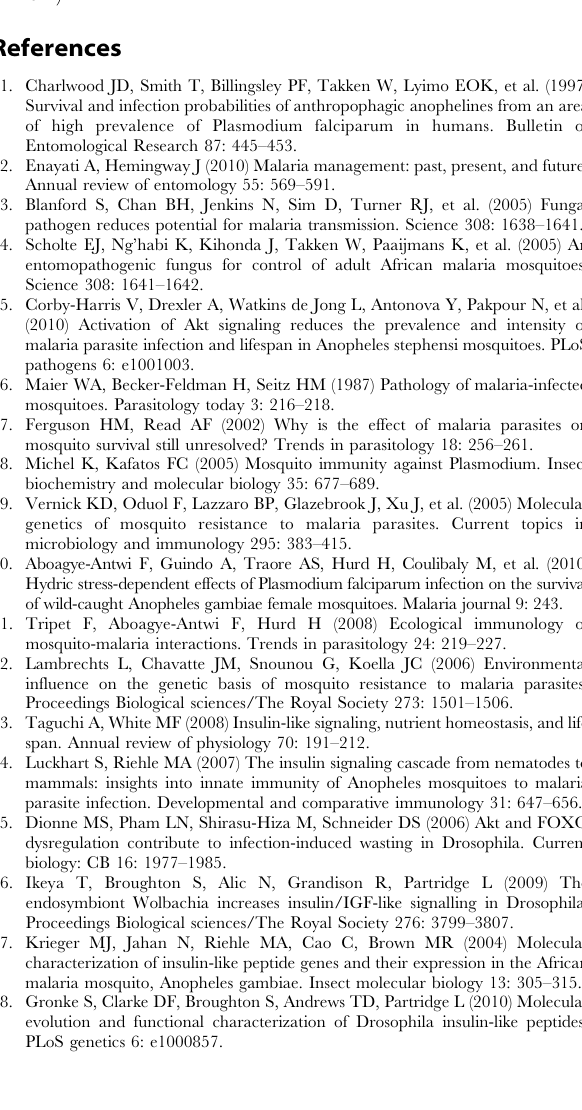
Table S2 DAVID Functional Annotation Clustering Results. Table S3 Fold-change values of representative probes targeting transcripts identified to be associated with carbohydrate catabolism. Table S4 Primer